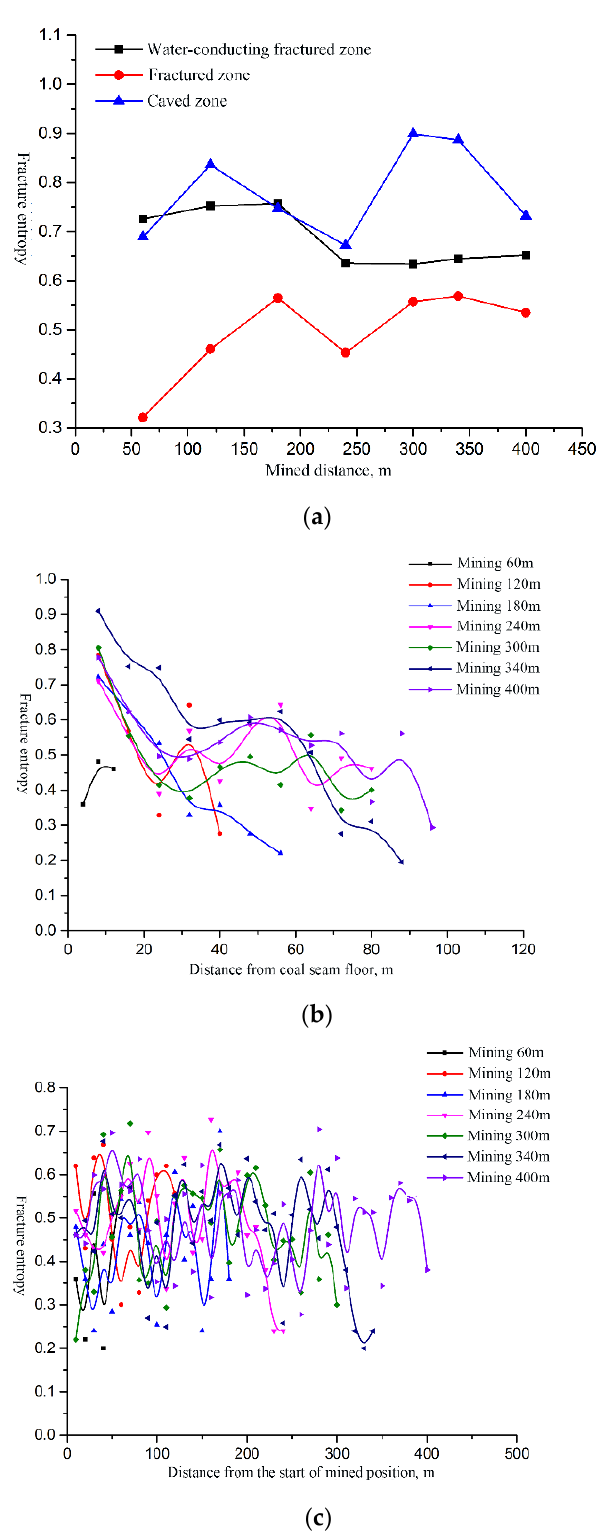
Figure 7. Spatio-temporal variation of fracture entropy of rock mass fractures: ( a ) due to mining; ( b ) in the vertical direction; and ( c ) in the mined direction.